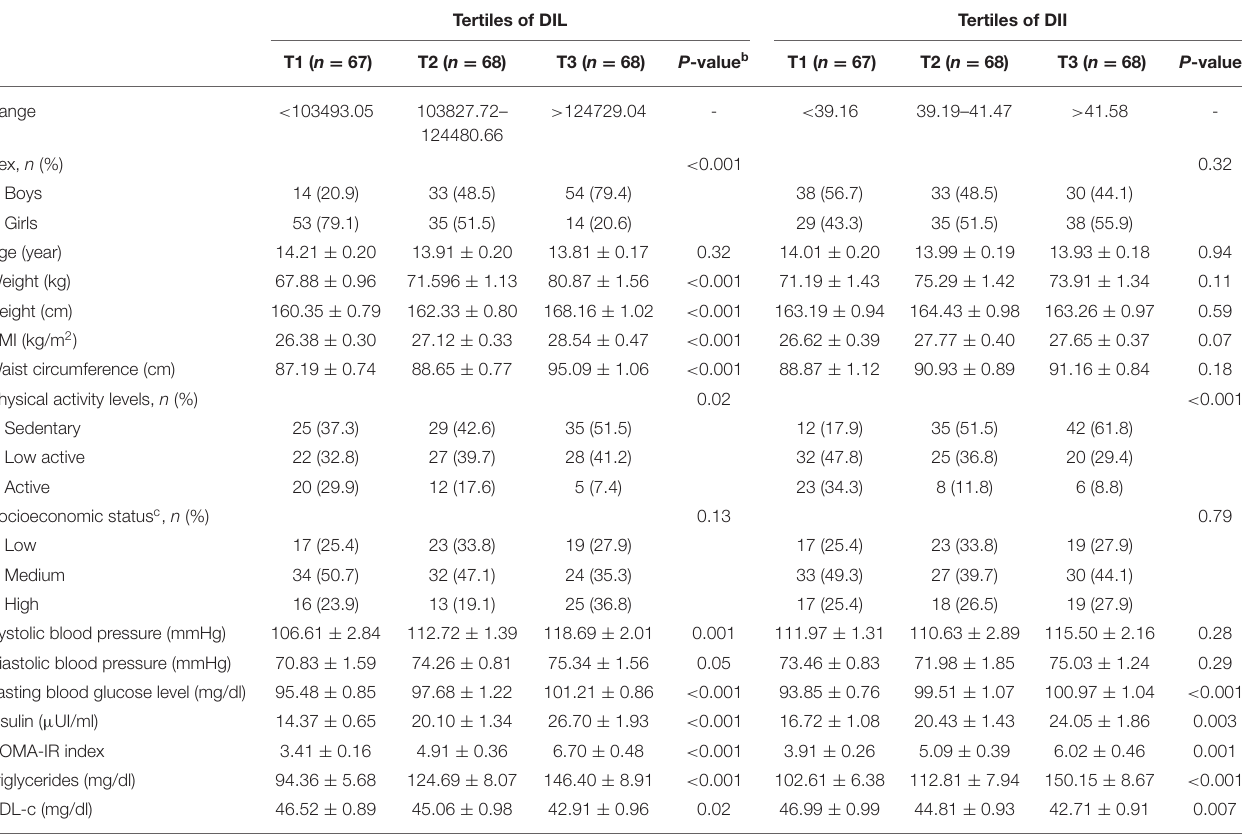
TABLE 1 | General characteristics and cardiometabolic factors of study participants across tertiles of DIL and DII a . Tertiles of